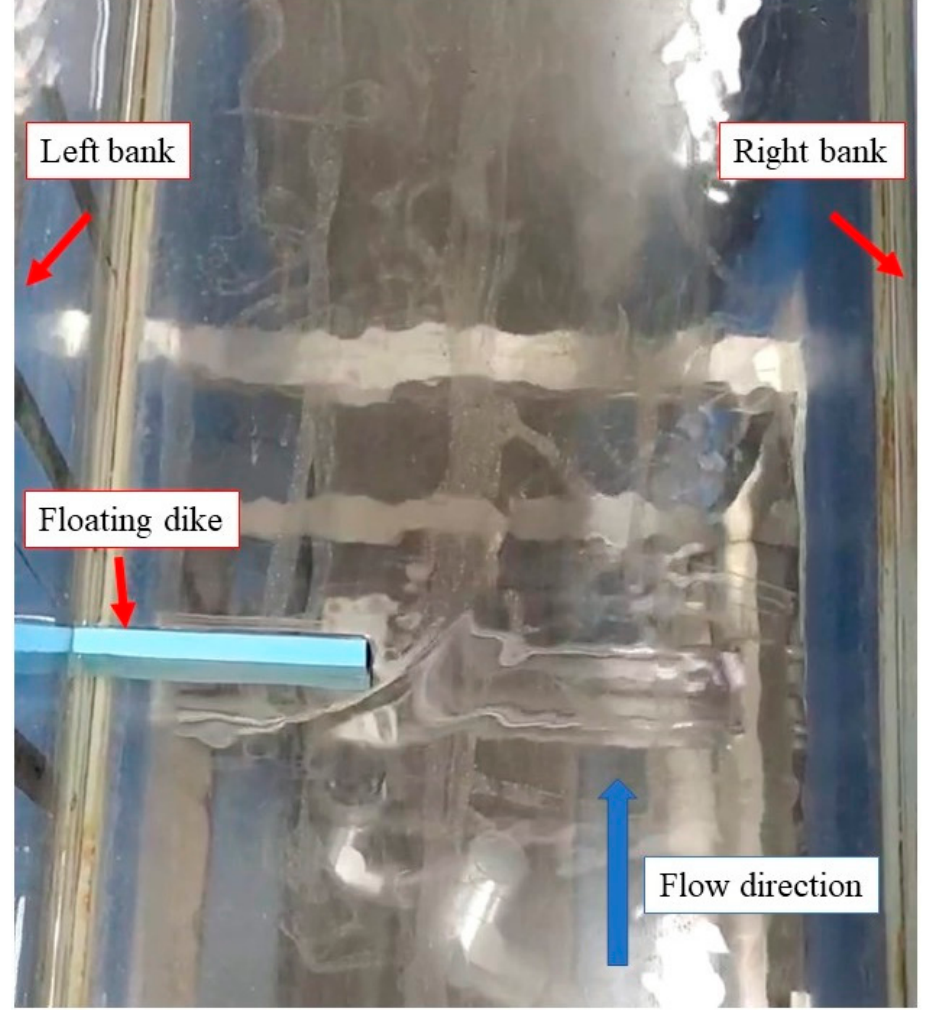
Figure 5. Photograph of the surface flow in Case 2.